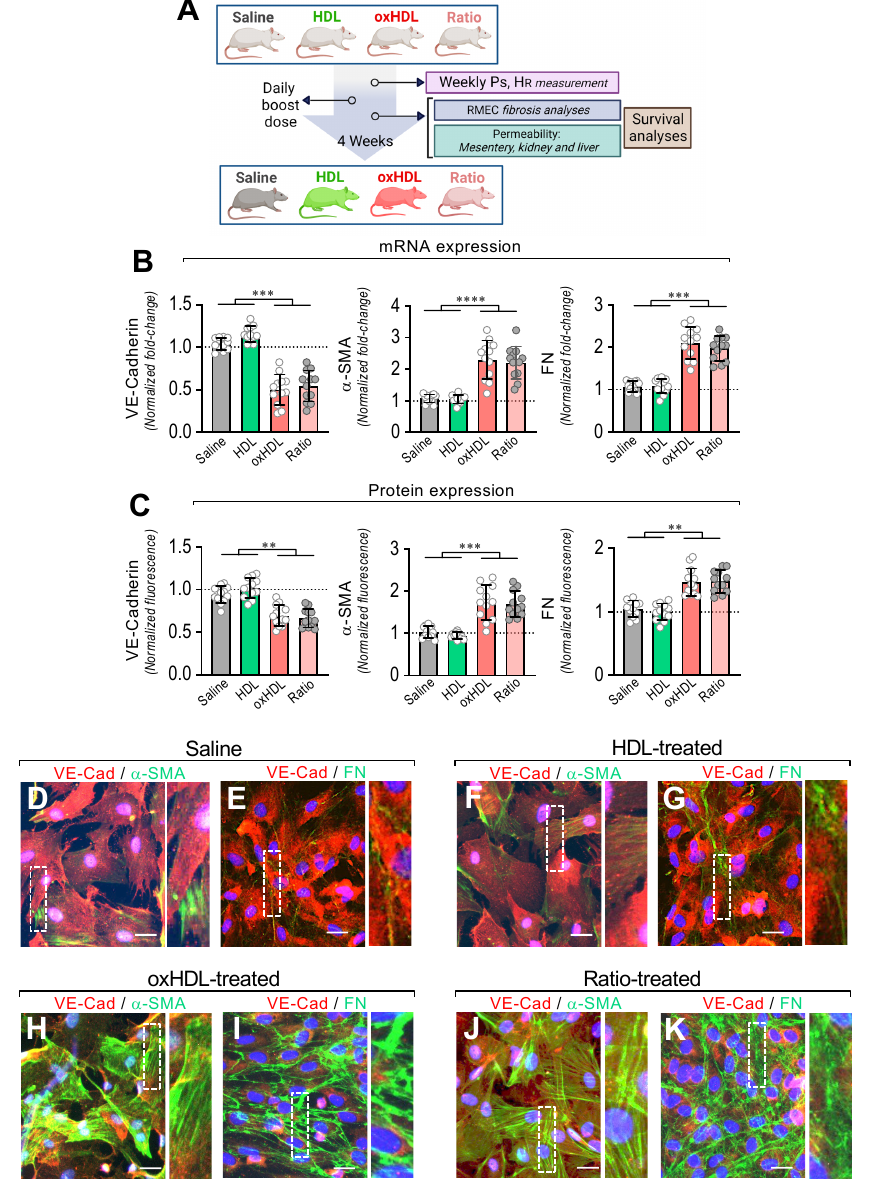
Figure 4. In vivo oxHDL administration induces endothelial fibrosis in rats. ( A ) Experimental strategy for in vivo oxHDL administration in rats and determination of several variables. Rats were treated with saline solution (saline, 0.9% NaCl), HDL (0.4 mg/kg), oxHDL (2 mg/kg), and oxHDL/HDL ratio (0.4/2 mg/kg) by intraperitoneal (I.P.) injection (200 µ L) daily for 4 weeks. Systolic pressure (P S ) and heart rate (H R ) were determined weekly. At the end of treatment, permeability analysis (mesentery, kidney, and liver) and fibrosis analysis in RMAEC were performed. Survival analyses were per- formed within the experiments. ( B , C ) After saline, HDL, oxHDL, and oxHDL/HDL ratio treatments, RMAECs were extracted and subjected immediately to determination of mRNA ( B ) and protein ( C ) expression of VE-cadherin (left panels), α -SMA (middle panels), and FN (right panels). (N = 12). Statistical differences were assessed by one-way analysis of variance (ANOVA) (Kruskal–Wallis) followed by Dunn’s post hoc test. **, p < 0.01; ***, p < 0.001; ****, p < 0.0001. Results are expressed as the mean ± SD. ( D – K ) After saline ( D , E ), HDL ( F , G ), oxHDL ( H , I ), and oxHDL/HDL ratio ( J , K ) treatments, RMAECs were extracted and subjected immediately to fluorescent immunocytochemistry for the detection of VE-cadherin (red), α -SMA (green), and FN (green). Scale bar represents 50 mm. (N =